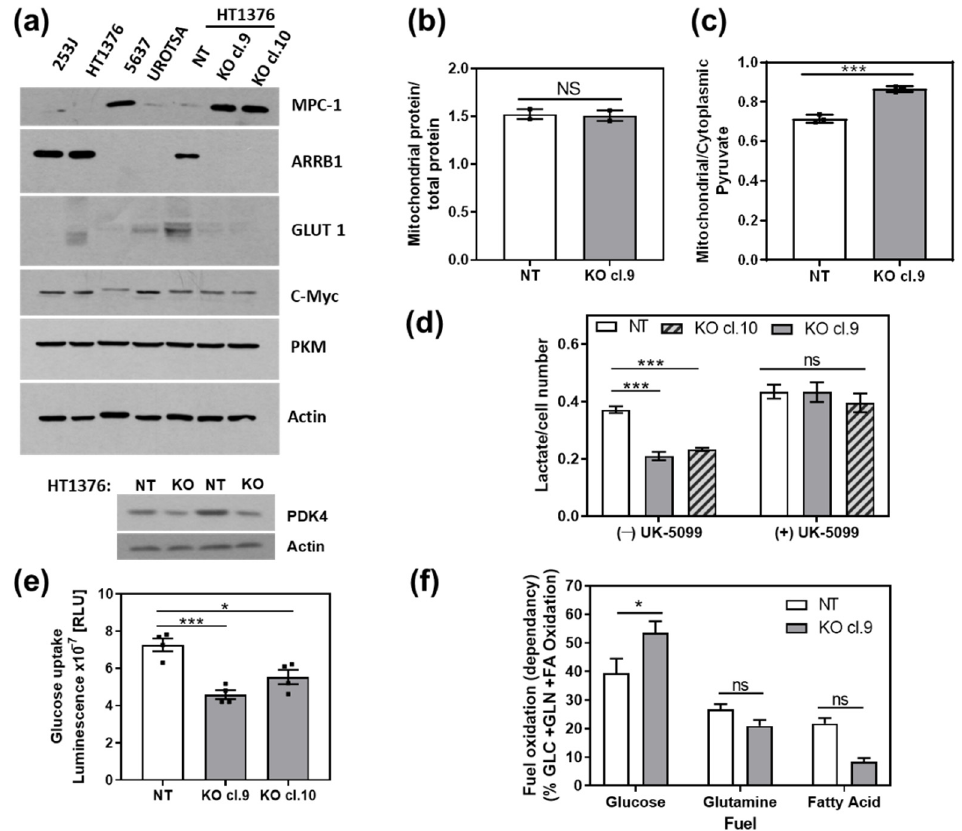
Figure 4. ARRB1 regulates mitochondrial translocation of pyruvate and glucose uptake: ( a ) immunoblot for detection of glycolytic markers, MPC1 and GLUT1 in bladder cancer cell lines (253J, HT1376, 5637) and nonmalignant cells (UROTSA), as well as ARRB1-depleted HT1376 cells (KO cl. 9 and cl. 10). ( b ) Mitochondria of ARRB1-depleted HT1376 cells (KO cl. 9) and corresponding controls (NT) were collected, and mitochondria/total protein ratio was calculated. Data: means ± SEM, n = 2. The experiment was repeated once ( c ) Mitochondrial and cytoplasmic extracts were collected for colorimetric detection of pyruvate. Data: means ± SEM, n = 3; *** p < 0.001 (two-tailed unpaired t test). The experiment was repeated once ( d ) Secreted Lactate (glycolysis) in presence or absence of the MPC1-inhibitor UK-5099. Data: means ± SEM, n = 4; *** p < 0.001 (two-way ANOVA). ( e ) Glucose uptake in ARRB1-depleted HT1376 cells (KO cl. 9 and cl.10) compared to corre- sponding controls (NT). Data: means ± SEM, n = 4; *** p < 0.001, * p < 0.05 (One-way ANOVA). ( f ) Measurement of mito- chondrial fuel usage dependency of ARRB1-depleted HT1376 cells to oxidize glucose/pyruvate, glutamine/glutamate, and long-chain fatty acids. Data: means ± SEM, n = 4 to 8; * p < 0.05, (two-way ANOVA). NS: not